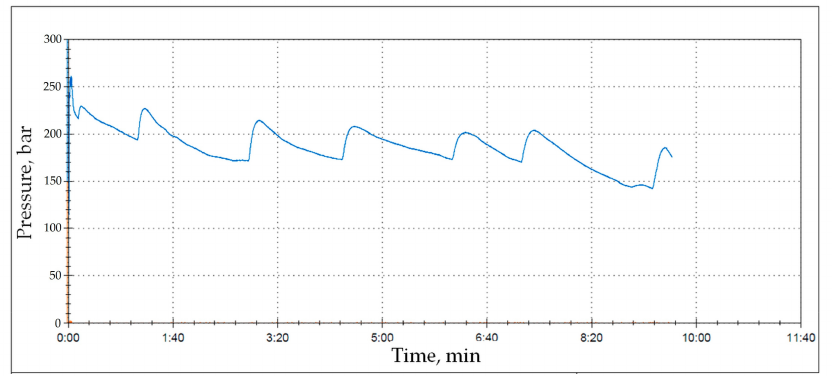
Figure 11. Measurement of pressure in the sub-piston space of the prop taking into account